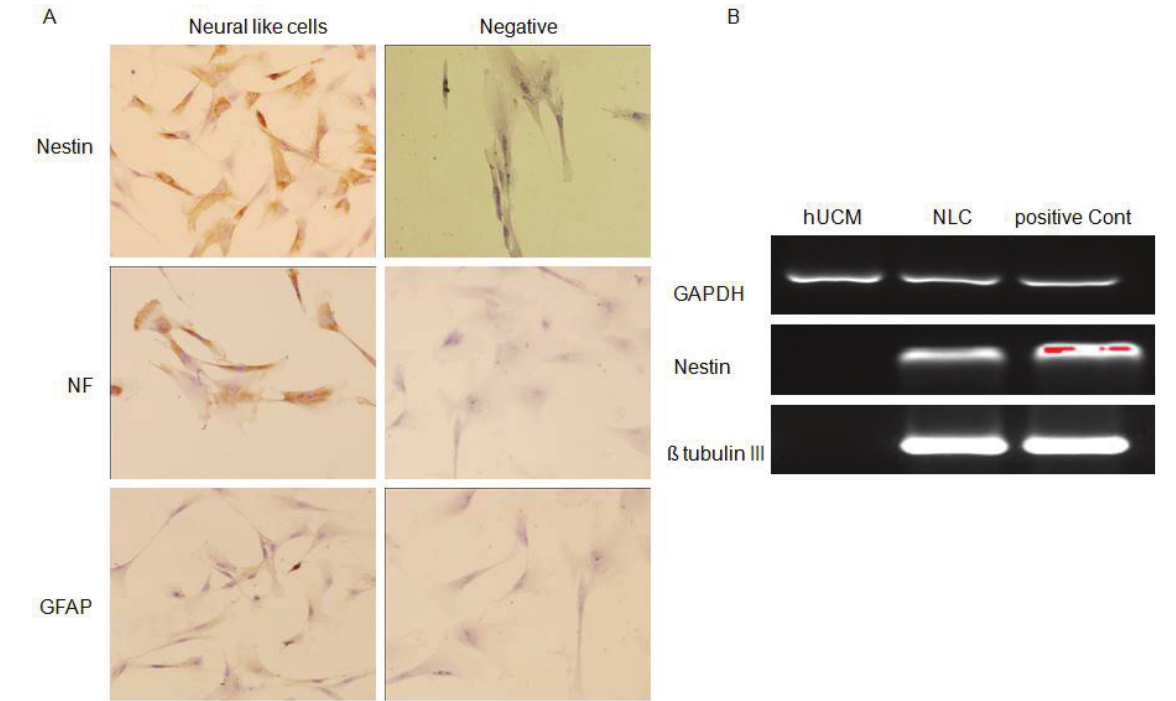
Fig. 10. Figure 10: (A) Images represent an expression of specific neural and glial markers by immunocytochemistry. Expression of nestin, NF and GFAP in differentiated hUCMs. Also, immunocytochemical staining of hUCMs were shown as a negative control. (In all images, original magnification ᵡ 400) (B) RT- PCR show expression of nestin and ß-tubulin ǀǀǀ in differentiated hUCMs. In addition, RT- PCR of hUCMs was applied as negative control.